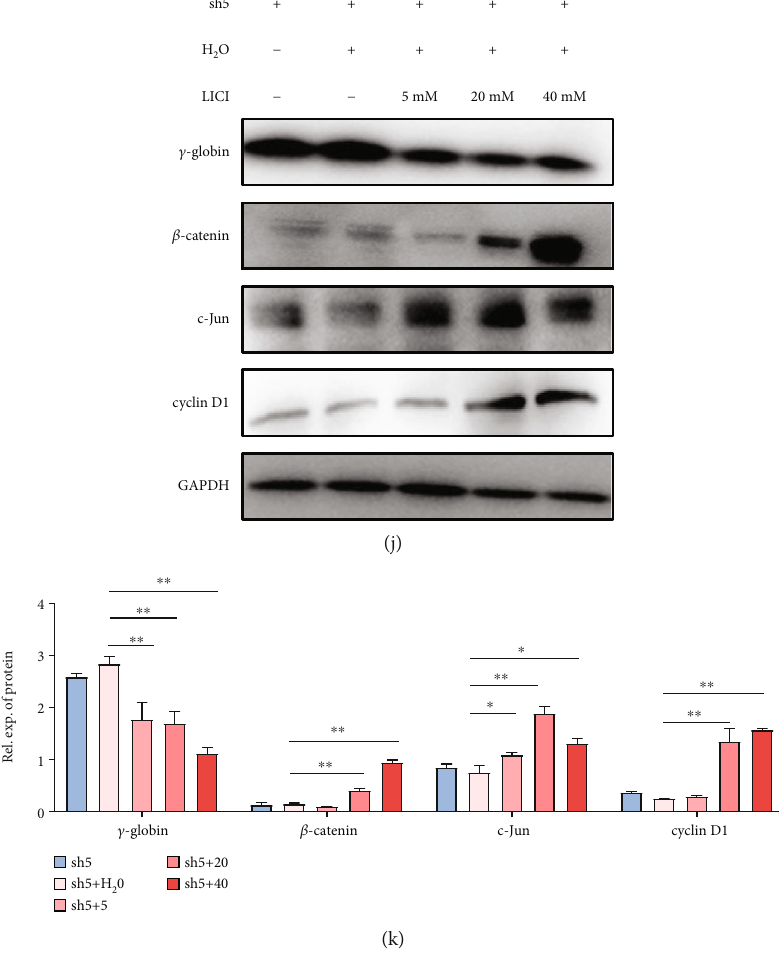
Figure 5: E ff ect of ANTXR1 on the expression of key molecules of the Wnt/ β -catenin pathway. (a) The mRNA expression levels of LRP6, β -catenin, c-Jun, and cyclin D1 were detected by qRT-PCR after overexpression of ANTXR1 in K562 cells. (b) The mRNA expression levels of LRP6, β -catenin, c-Jun, and cyclin D1 were detected by qRT-PCR, after K562 cells were transfected with ANTXR1- sh5. (c) The protein levels of LRP6, β -catenin, c-Jun, and cyclin D1 were measured by western blotting after K562 cells were overexpressed or knocked down by ANTXR1 . (d, e) Quanti fi cation of the western blots is shown in (c). (f, g) The mRNA and protein expression levels of γ -globin, LRP6, β -catenin, c-Jun, and cyclin D1 were detected by qRT-PCR and western blotting, respectively, with K562 cells overexpressing ANTXR1 treated with 2.5, 5, and 10 μ mol/L of XAV939 for 24h. (h) Quanti fi cation of the western blots shown in (g). (i, j) The mRNA and protein expression levels of γ -globin, LRP6, β -catenin, c-Jun, and cyclin D1 were detected by qRT-PCR and western blotting, respectively, with K562 cells interfering with ANTXR1-sh5 which were treated with 5, 20, and 40mmol/L of LiCl for 24h. (k) Quanti fi cation of the western blots shown in (j). These experiments n = 3 . The error bar represents the SD. ∗ P < 0 : 05 , ∗∗ P < 0 : 01 . NC: negative